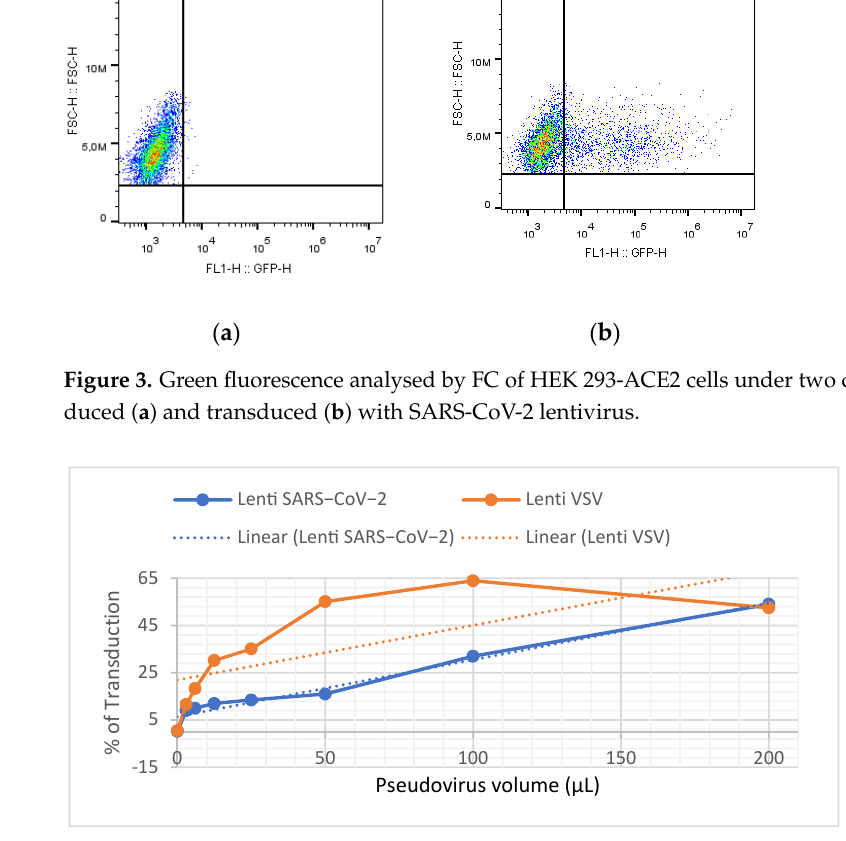
Figure 4. Titration of LV spike SARS-CoV-2 and LV VSV on HEK293-ACE2 cells.